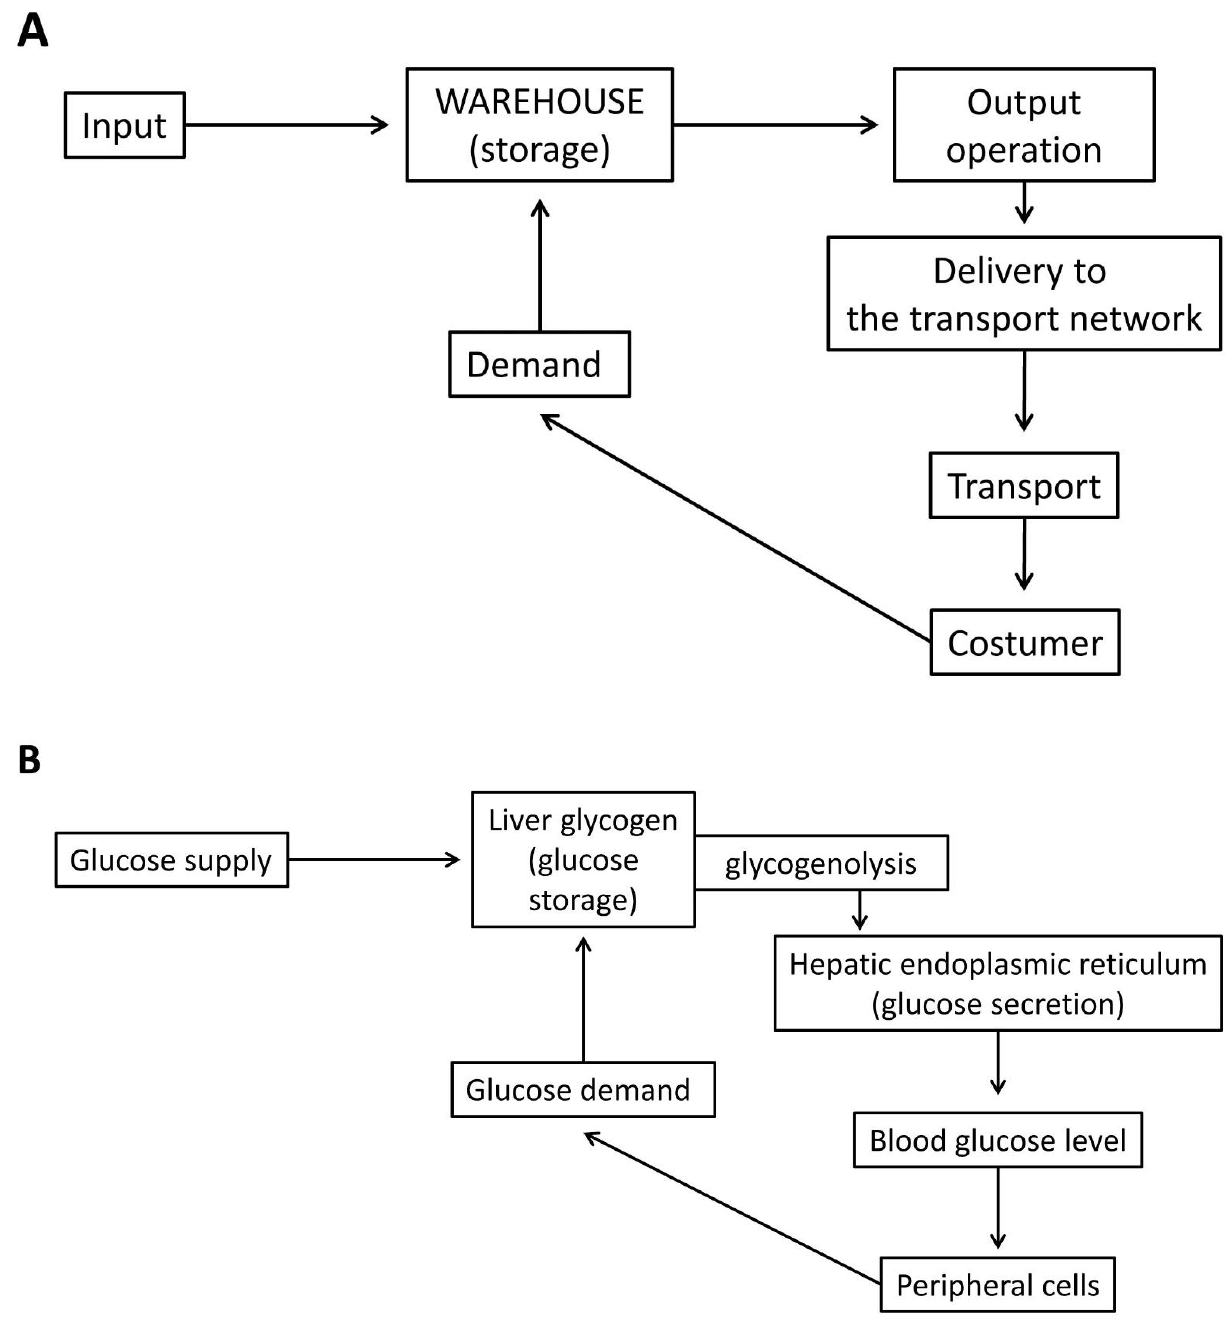
Figure 1. In the general logical scheme of warehousing, the product stored in the warehouse travels from the central warehouse to the consumer via a transport network. An important step in the sequence of events is the delivery of the product from the warehouse to the transport network ( A ). A huge amount of glucose molecules stored in form of glycogen can reach the peripheral cells via the bloodstream. The “output operation” is realized mainly through glycogenolysis. The necessary enzyme-machinery for glycogen degradation is part of the glycogen particle. However, the final step of the output operation occurs in another cell organelle, the endoplasmic reticulum (ER). This operation requires another enzyme reaction catalyzed by the ER membrane bound glucose-6 phosphatase enzyme — transporter system, thereafter glucose is secreted into circulation. ER is needed for establishing this connection between the storage molecule and the bloodstream ( B ).